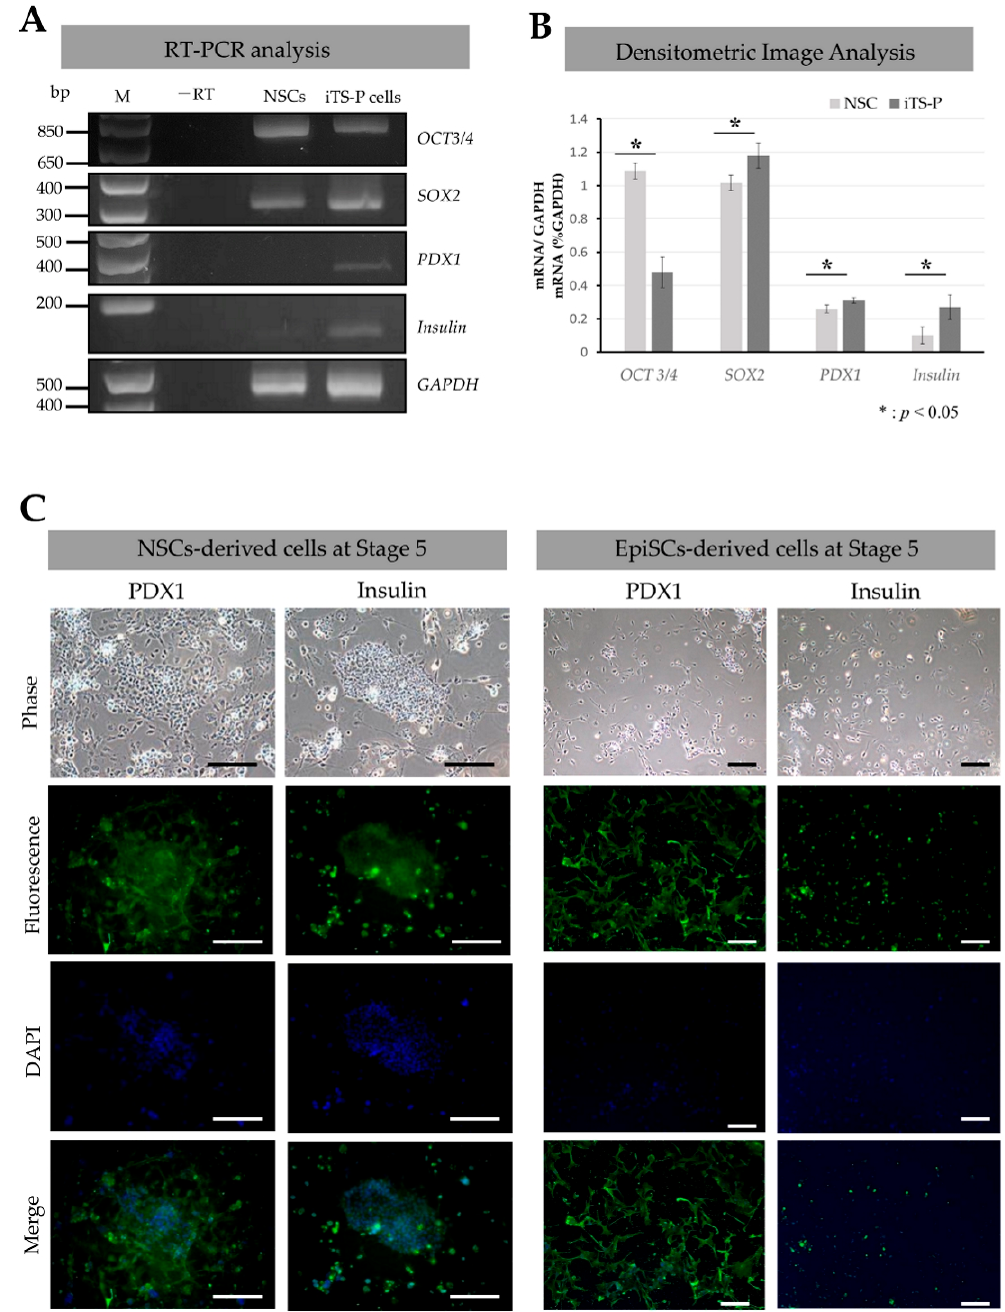
Figure 3. Reverse transcription-polymerase chain reaction (RT-PCR) and immunocytochemical analyses. ( A ): Agarose gel electrophoresis of RT-PCR products derived from naïve stem cells (NSCs) and induced tissue-specific stem cells for pancreatic cells (iTS-P) (collected at 16 days after induced di ff erentiation into pancreatic β -cells). M, 100-bp ladder markers; -RT, no template (water alone) as negative control. ( B ): Comparison of expression levels of each transcript between NSCs and iTS-P cells after normalization. Each band shown in A was scanned using ImageJ software. The level of each transcript was normalized with that of GAPDH mRNA, and the results obtained are shown in the form of a graph. ( C ): Immunocytochemical staining of NSC-derived cells at Stage 5 and EpiSC-derived cells at Stage 5 with anti- PDX1 (Green) and anti-insulin (Green) antibodies. Bar = 100 µm.